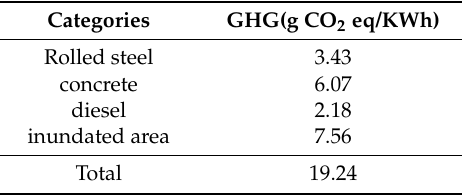
Table A4. Lifecycle greenhouse gas emissions of hydropower (g CO 2 eq/KWh).